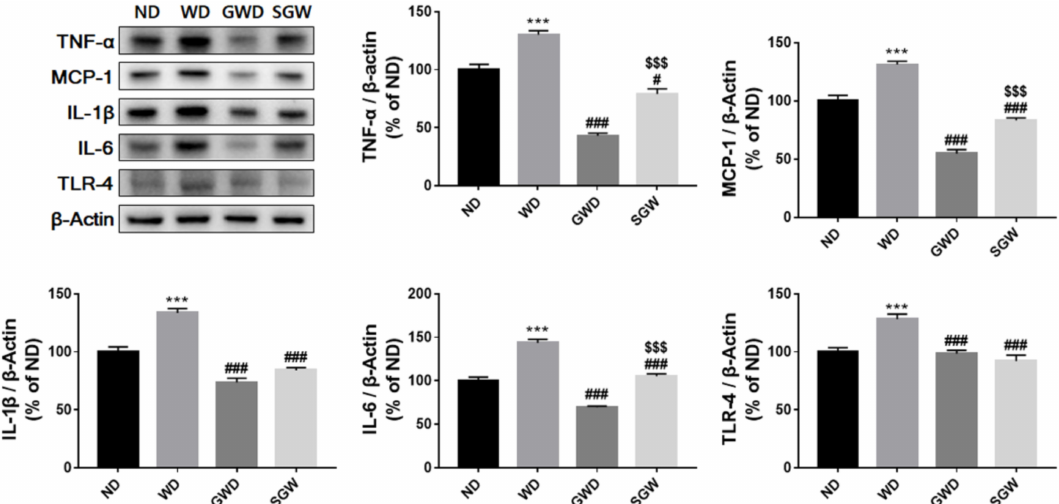
Figure 5. Diet-induced change of inflammatory cytokines’ expression in the liver. Band intensities were normalized to those of β -actin and bar values are presented as the mean percentage of ND ± SEM of three independent experiments (* p < 0.05, *** p < 0.001 vs. ND; # p < 0.05, ### p < 0.001 vs. WD; $$$ p < 0.001 vs.